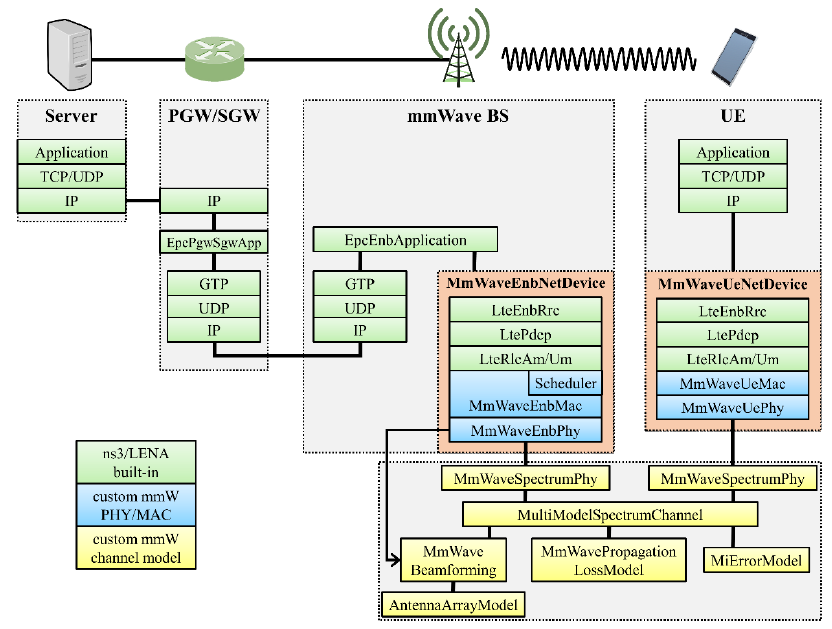
Figure 7. Ns-3-based 5G mmWave module architecture from an end-to-end perspective [36].